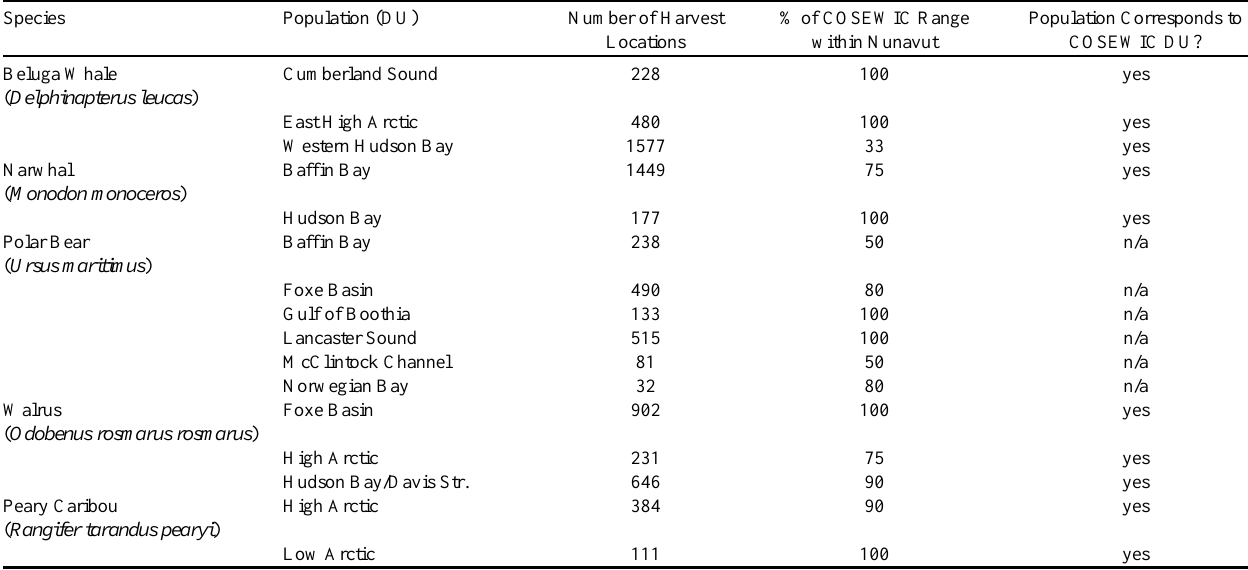
Table 1 . Study group: Inuit knowledge mammal species and subpopulations (Committee on the Status of Endangered Wildlife in Canada = COSEWIC; designatable units = DUs).